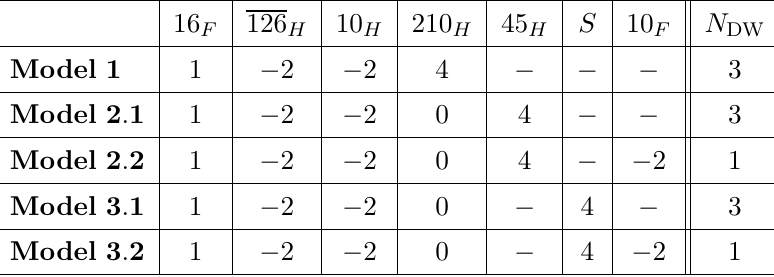
Table 5 . Field content, PQ charge assignments, and resulting domain wall number N DW in the various SO(10) (cid:2) U(1) PQ models considered in this